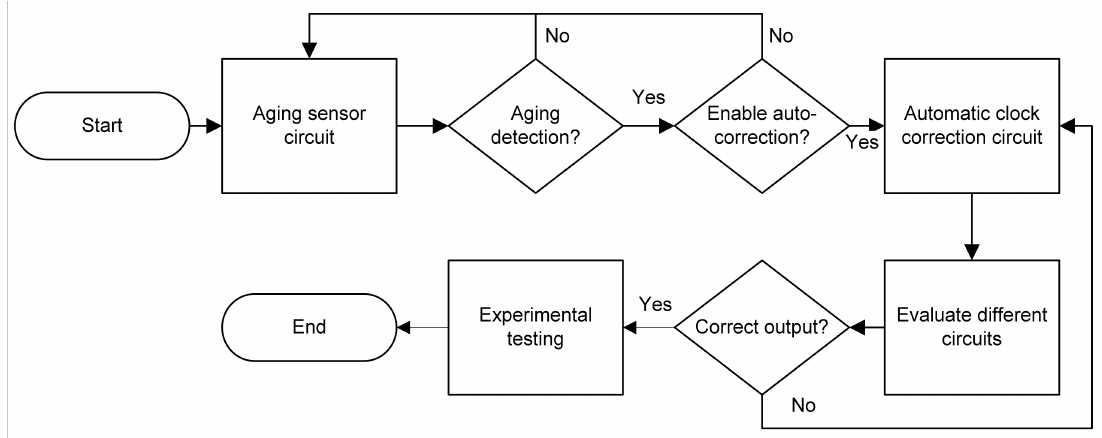
Figure 8. Flow chart for automatic clock